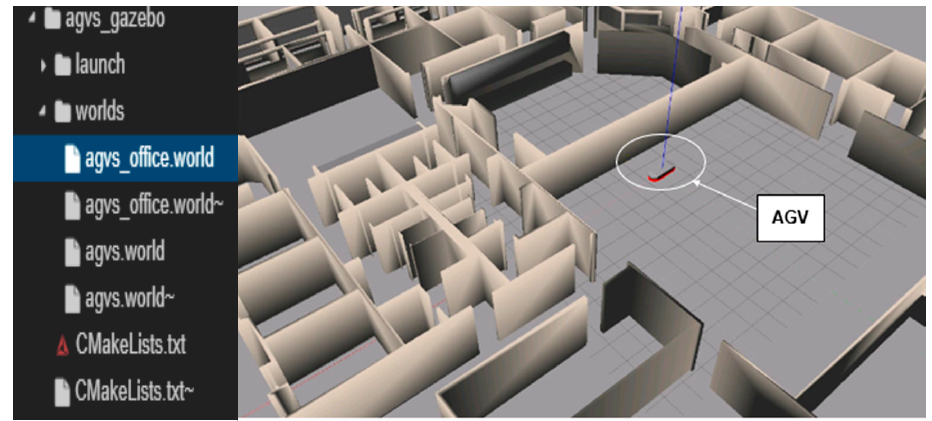
Figure 19. 3D model of a factory in Gazebo.